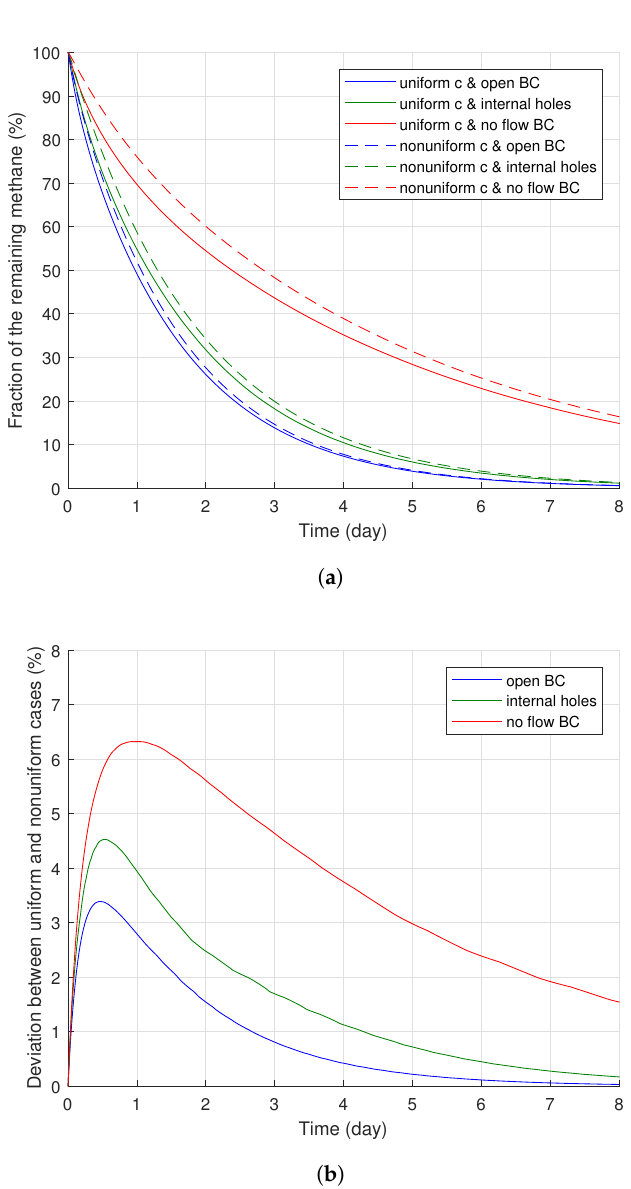
Figure 13. Methane degassing data with either a uniform or a nonuniform methane distribution. ( a ) Remaining methane changes over time; ( b ) deviation of the methane between uniform and nonuniform